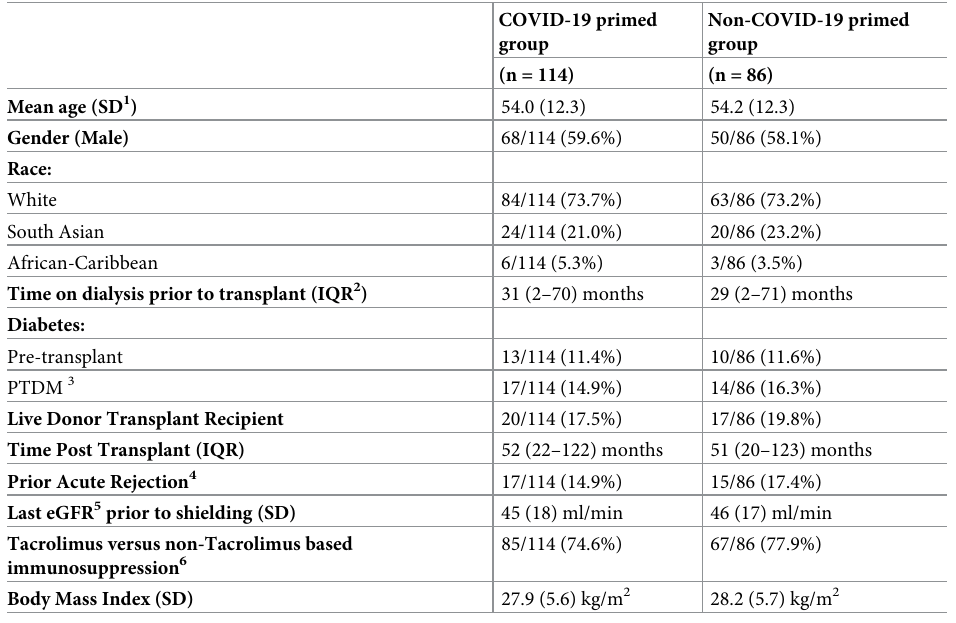
Table 1. Summary of participant